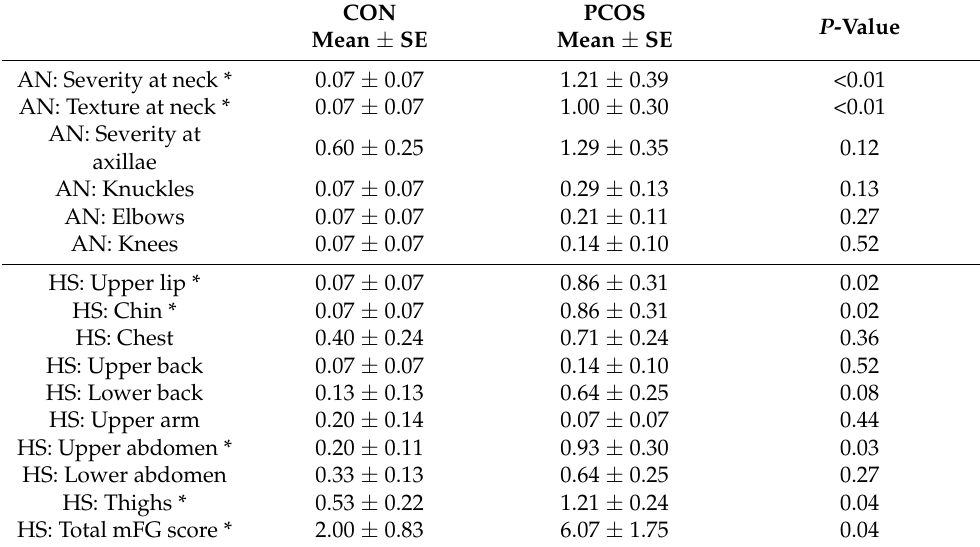
Table 3. AN and hirsutism